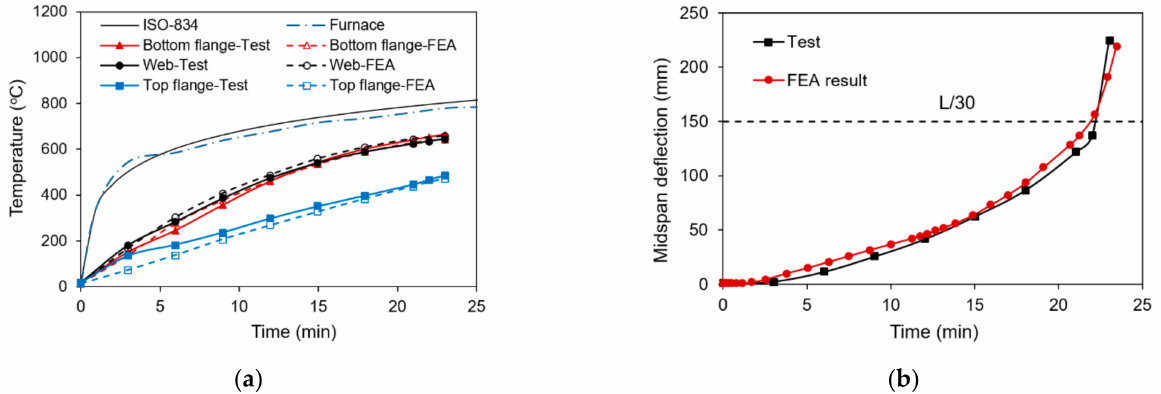
Figure 8. Comparison of FEA results and test data: ( a ) Temperature in steel beam; ( b ) Midspan deflection during fire.